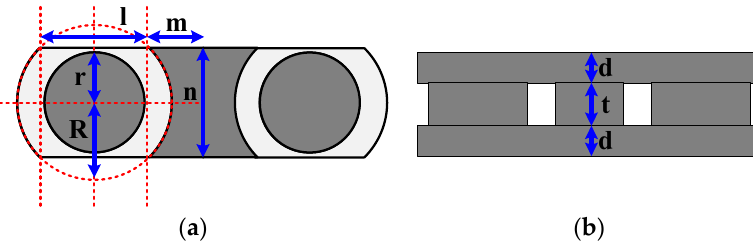
Figure 10. Diagram of the core size marking: ( a ) top and ( b ) side view.